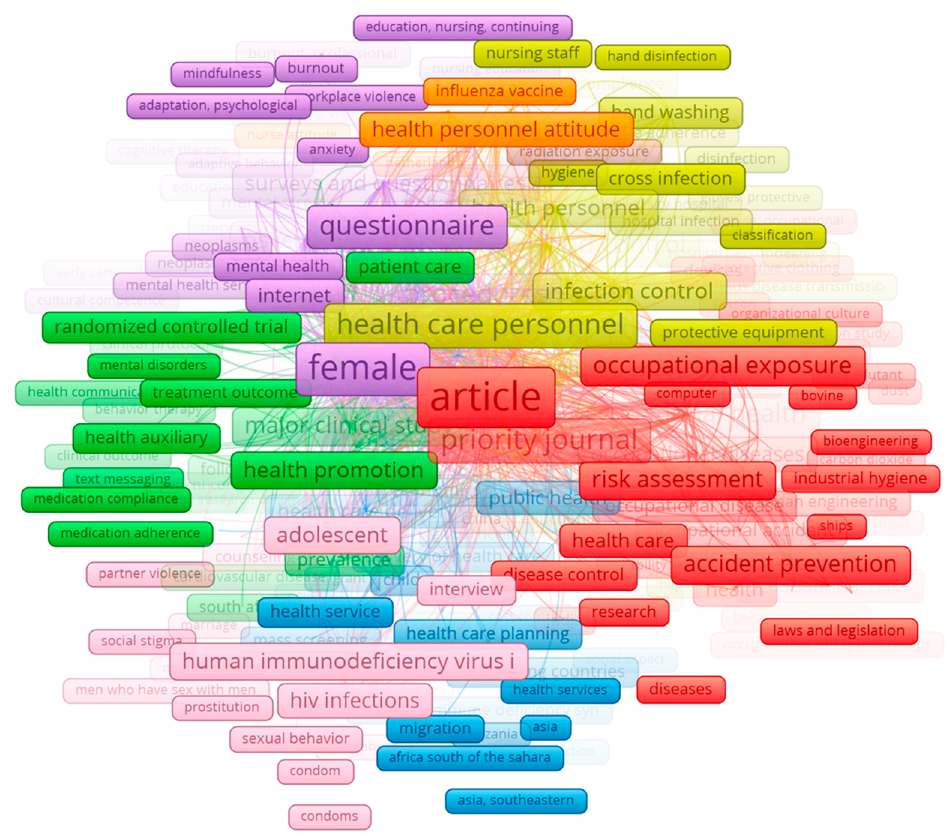
Figure 6. Co-occurrence of most common index terms per document. Note: the colors of the nodes indicate principal components of the data structure; the node size was scaled to the index keywords’ occurrences.